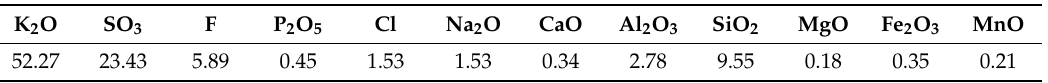
Table 6. Contents of potassium sulfate product after evaporator crystallization (leaching time 30 min, leaching temperature 60 °C, liquid-to-solid ratio 20, wt.%).